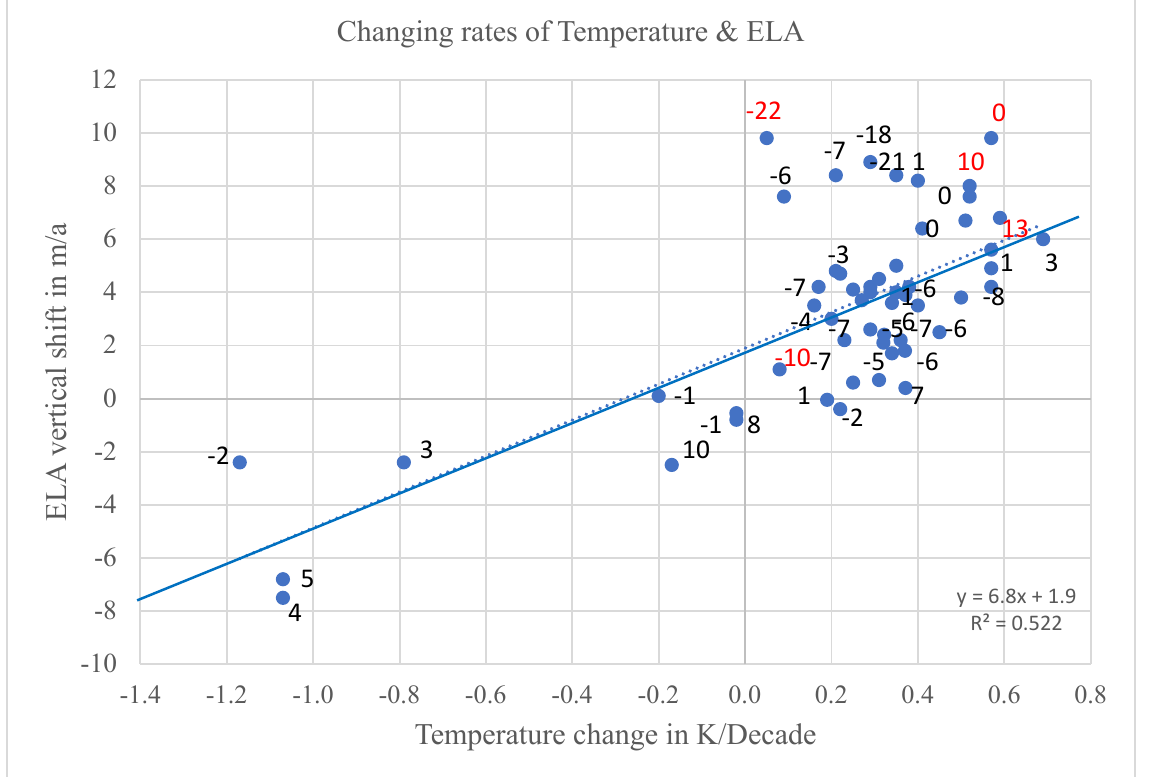
Figure 3. The relationship between the ELA shift rate (m/a) and the decadal temperature change (K/decade). Each dot represents a glacier with accompanying number representing the annual change in Bw (mm/a). The changing rate of the winter balance (Bw) marked in red represents the glaciers discussed in the text (from top left, Lemon Creek, Basodino, Hintereis, Gries, and Hofs E). The dot-line is the best fit regression line on the E/T plane. The solid straight line is the interseption of the best fit plane discussed in the text with the Bw = 0 plane. The proximity of these two lines indicates a good accuracy of the plane.